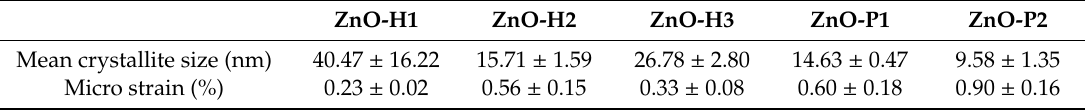
Table 1. Mean crystallite size and micro-strains determined from the XRD patterns for ZnO powders.